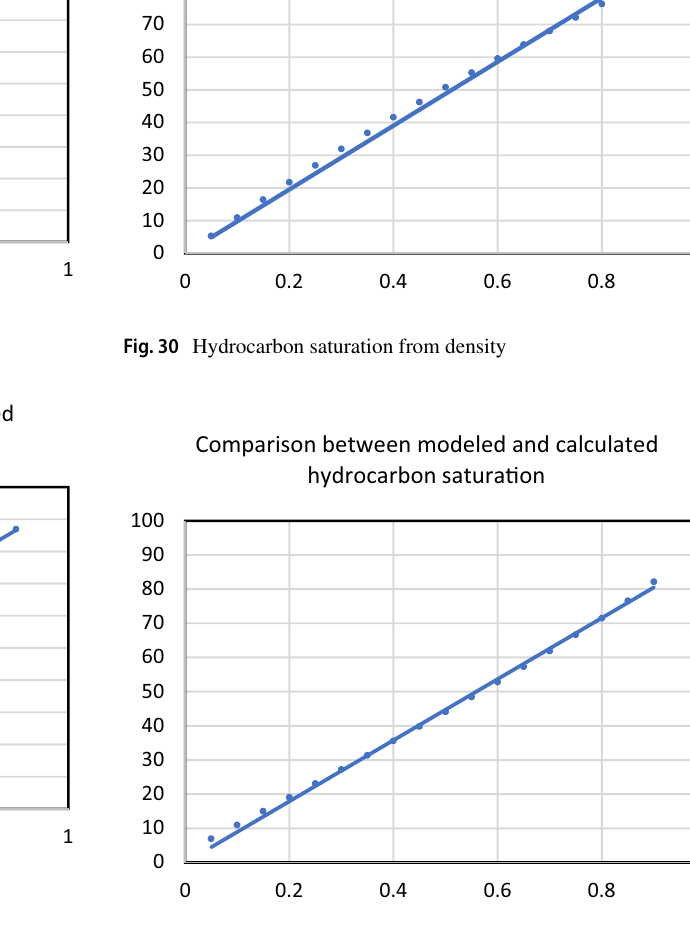
Fig. 31 Hydrocarbon saturation from